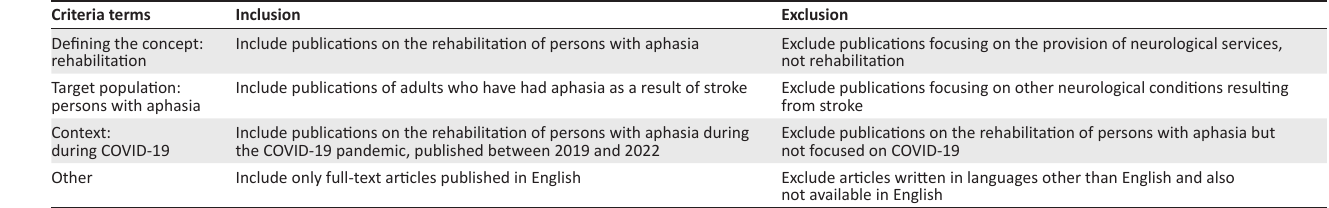
TABLE 1: Criteria for selecting